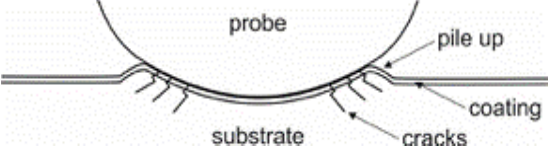
Figure 1. Location of taken cross section of the impact spot with an indication of the individual zones and layers.